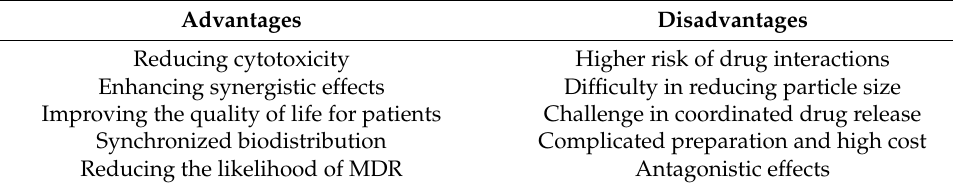
Table 6. Summary of the benefits and drawbacks of co-delivery